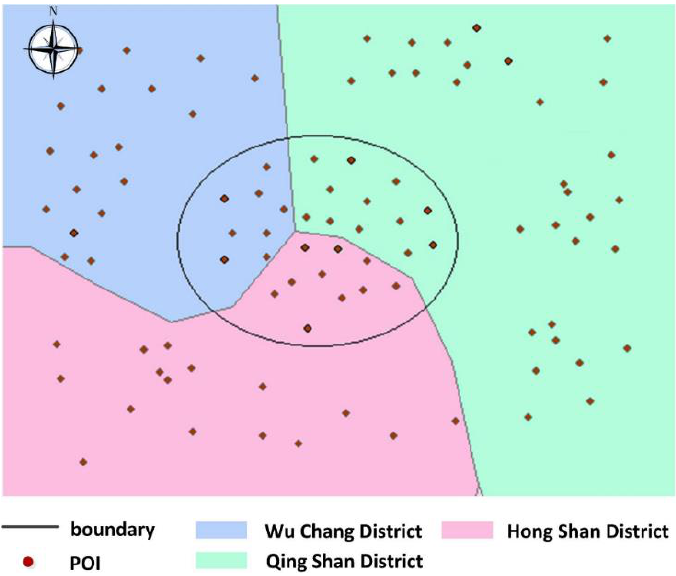
Figure 1. No constraints based on the district feature are included, resulting in unreasonable clustering.